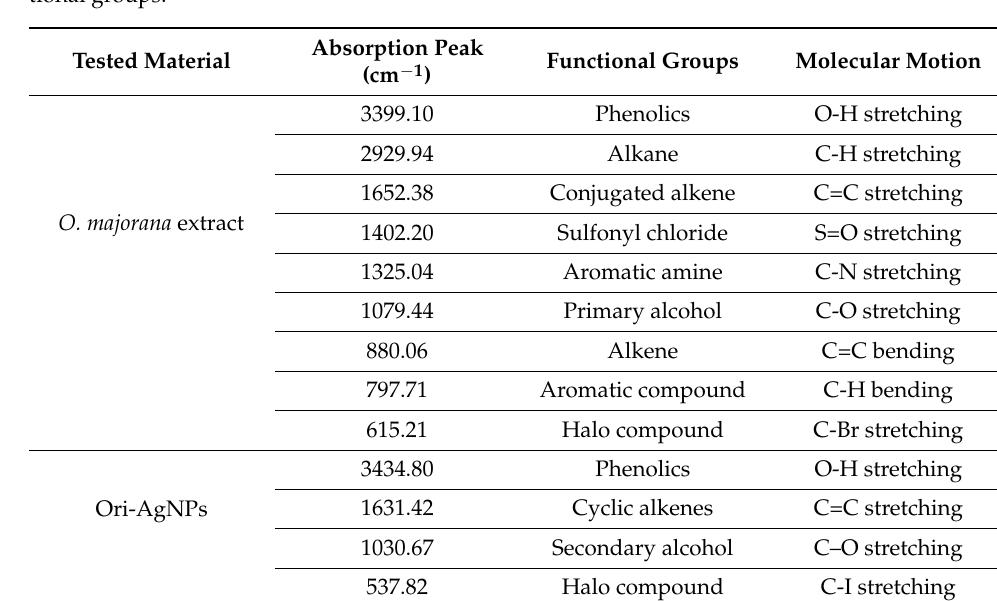
Figure 7. FTIR spectrum of AgNPs synthesized using aqueous extract of Origanum majorana extract. Table 1. FTIR analysis of O. majorana extract and the biogenic AgNPs showing different func- tional